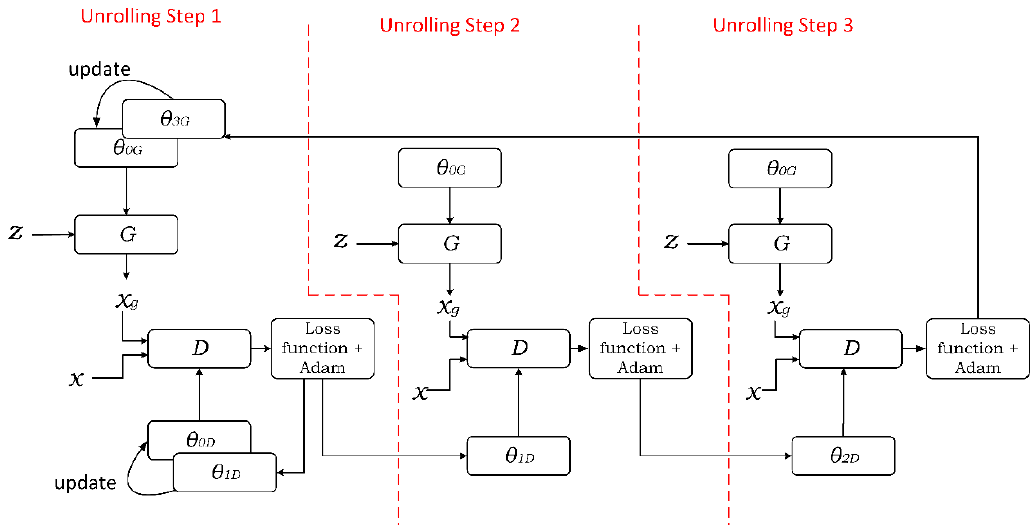
Figure 3. n -step Unrolled GAN for data augmentation. For the sake of clarity, consideration in this figure is limited to the case of n = 3, with z denoting a random vector and x standing for the empirical data vector (input), x g representing the synthetic data vector produced by generator G , D standing for the discriminator, θ 0 G representing the initial parameter vector of G , θ 3 G representing the generator parameters for the three unrolling steps, θ 0 D representing the initial parameter vector of D , and θ kD , k ∈ { 0,1, n − 1 } signifying discriminator parameters at the k th unrolling